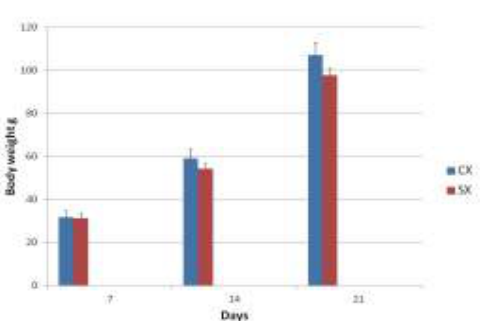
Figure-1. Effect of feeding SBT leaves on body weights (Mean ± SEM) of Japanese quail at different intervals (N=9).